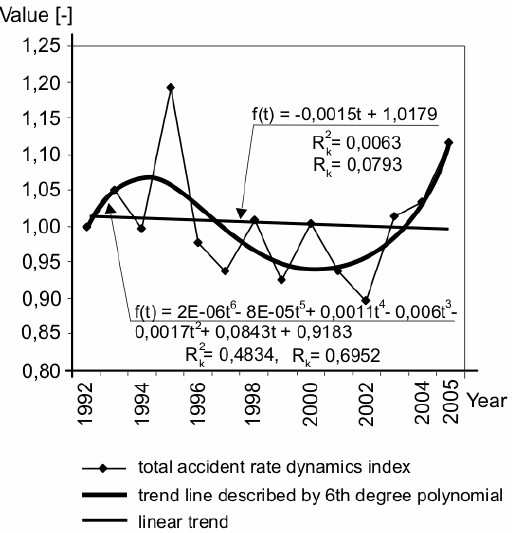
Fig 7. Total construction work accident rate dynamics in 1992–2005